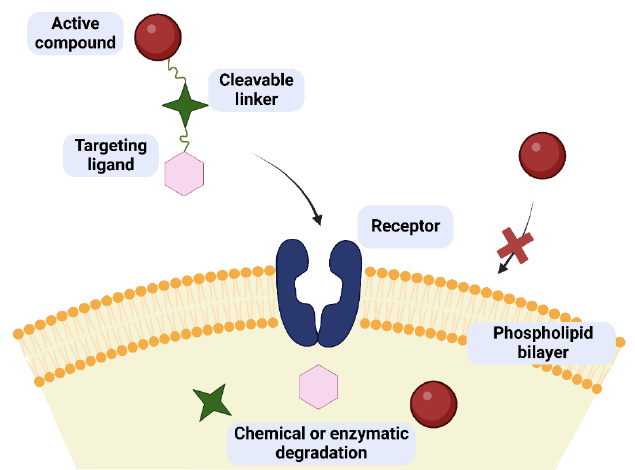
Figure 1. Concept of drug/glycoconjugate targeting in cancer therapy. The targeted drug can cross the cell membrane as opposed to the pure active compound. Inside the cell, the prodrug breaks down into its component parts.